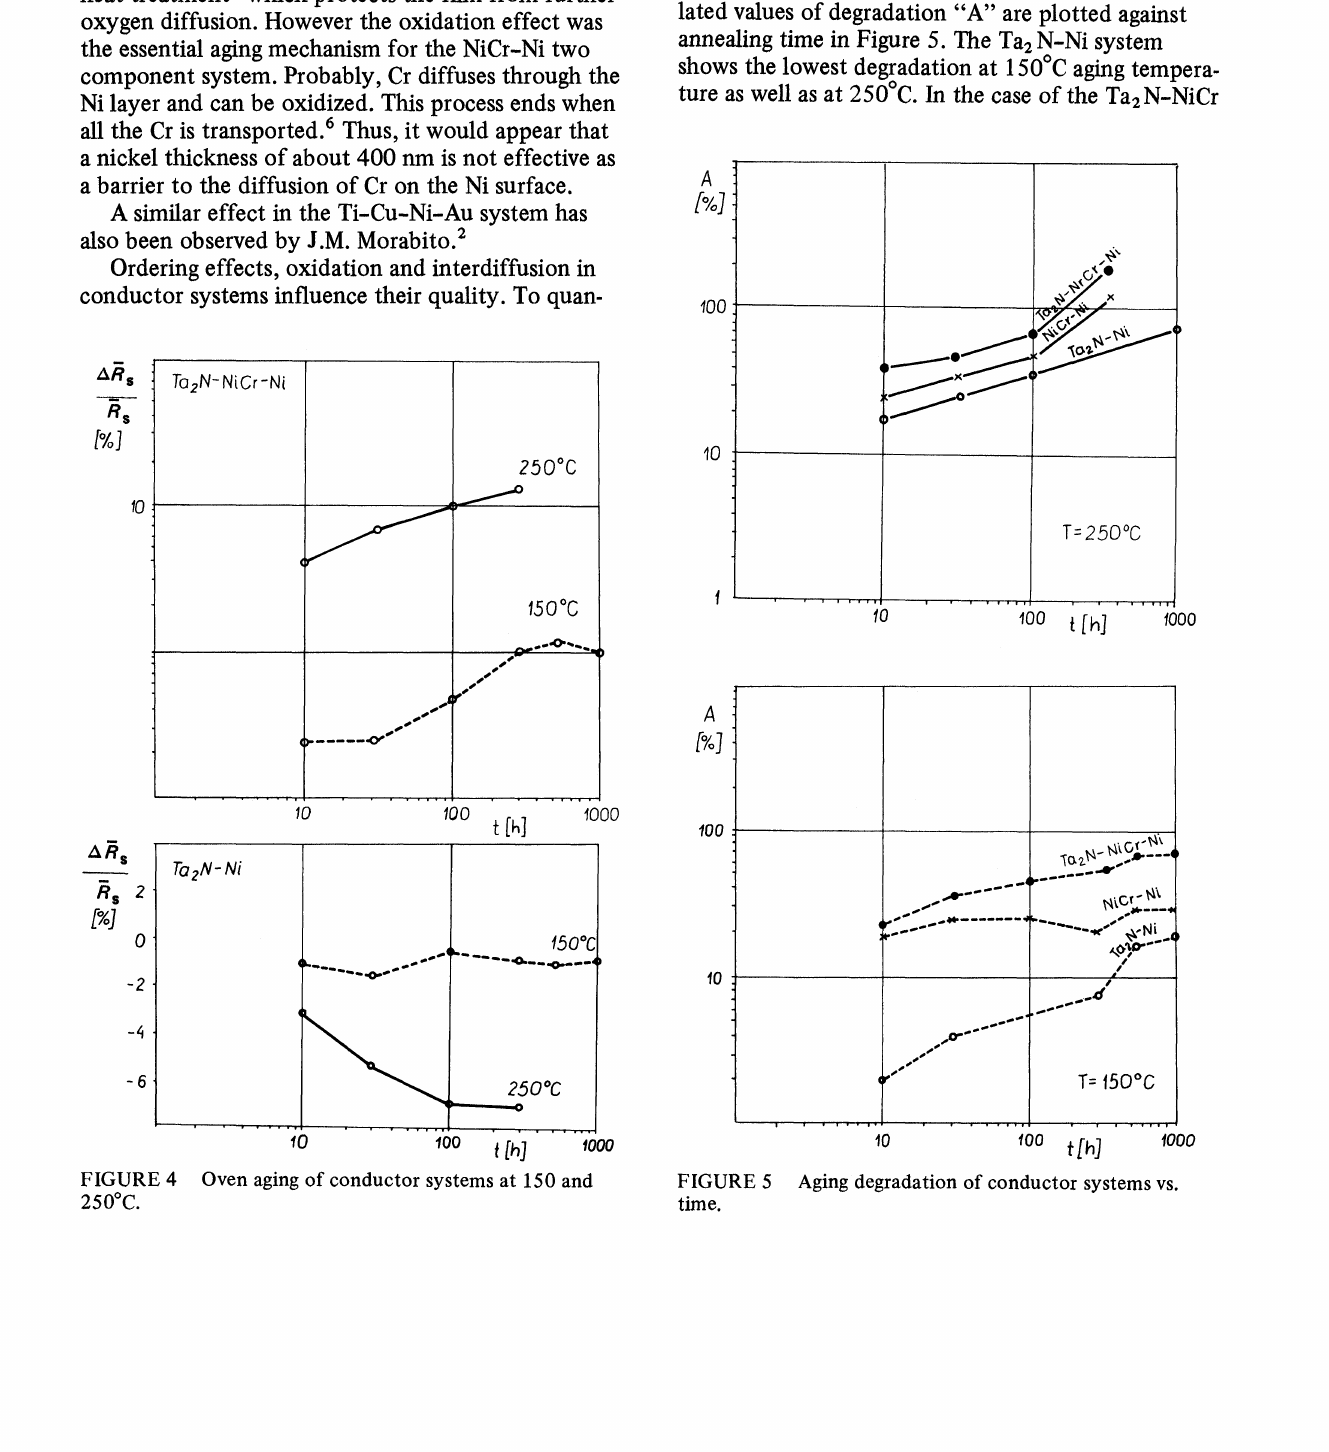
FIGURE 5 Aging degradation of conductor systems time.